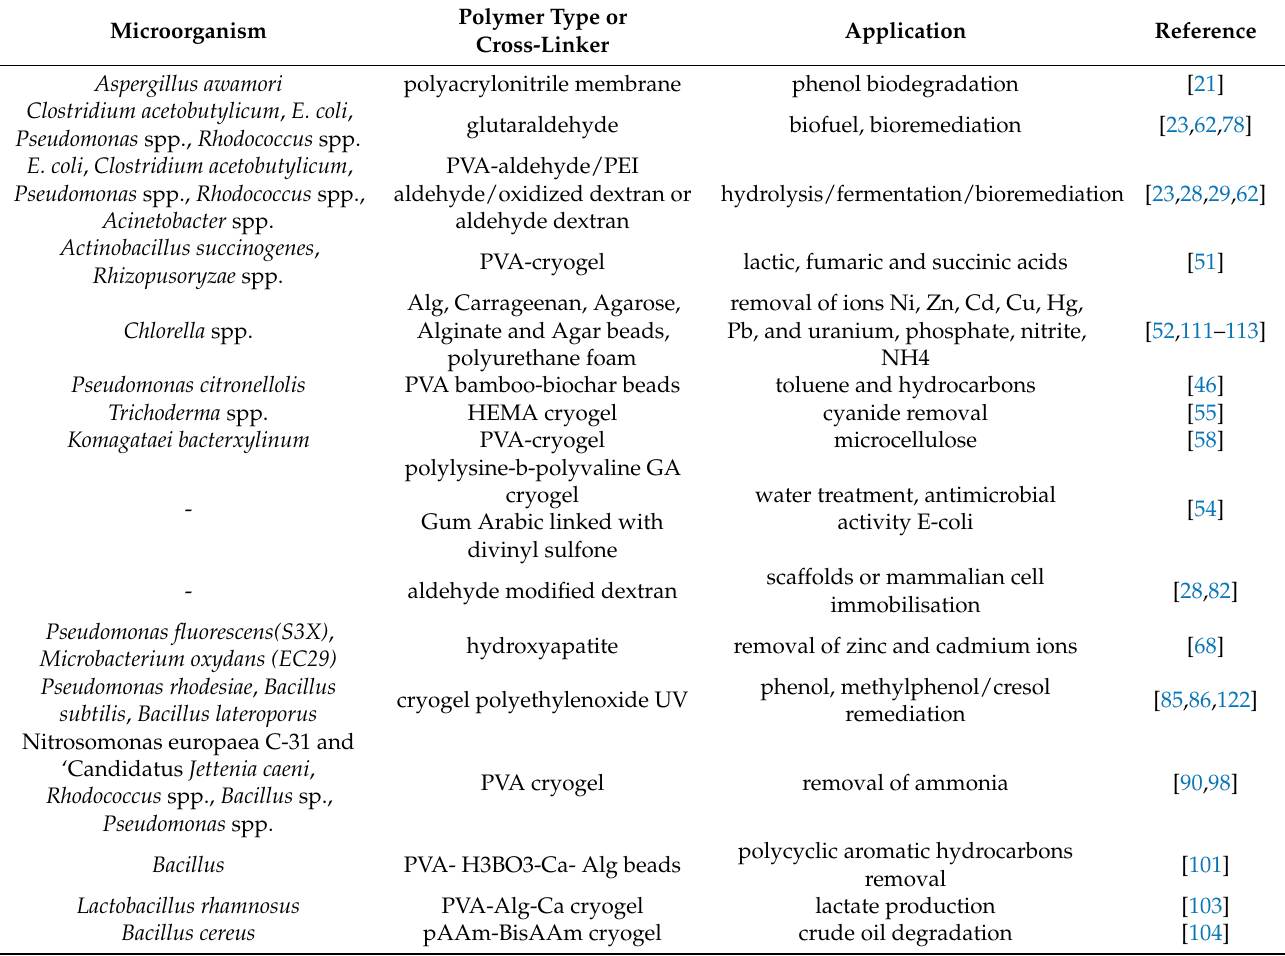
Table 1. Comparative analysis of polymer used for immobilization of cells and its application. Polymer Type or Microorganism Cross-Linker